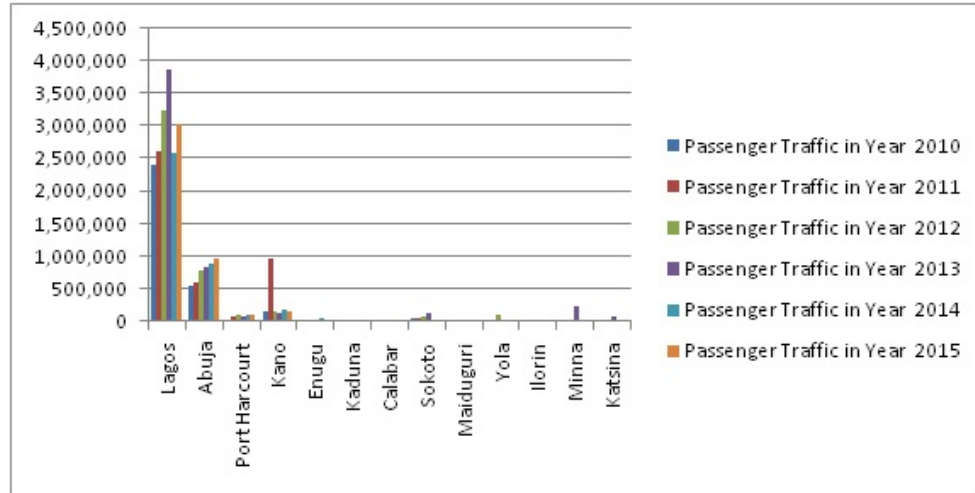
Figure 2. Bar chart international air passenger traffic in different airports in Nigeria from year 2010 to year